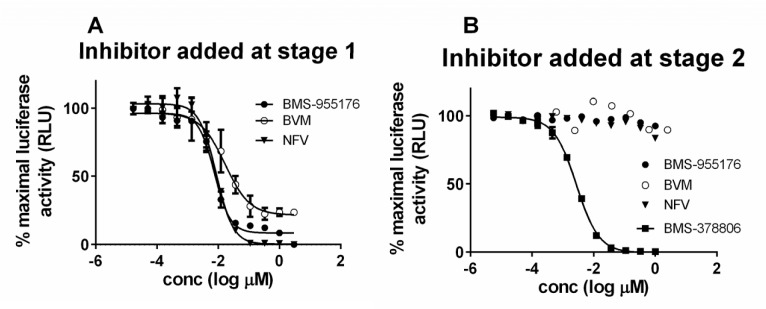
Antiviral profiles of selected ARVs of differing mechanism of action in the SC Assay.A) Test compound added during transfection to produce LAI pseudotyped NLRepRlucP373 Δenv and evaluated for activity by infections in stage 2, as described in text; B) Virus produced by transfection, test compound added at the second stage of virus infection, as described in text; BMS-955176 (MI, filled circles); BVM (MI, open circles); nelfinavir (protease inhibitor, triangles), BMS-378806 (HIV attachment inhibitor, squares).